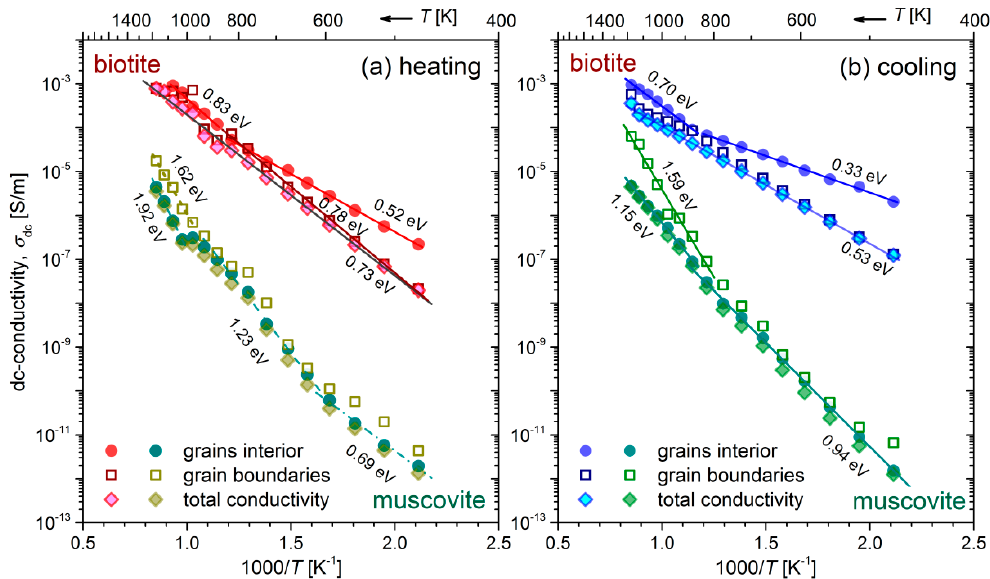
Figure 4. Arrhenius plots of dc-conductivity during the heating-cooling cycle of biotite and muscovite mica samples, during ( a ) gradual heating to 1173 K and ( b ) subsequent cooling to 473 K. The thermal activation energies E a are denoted for each linear region of the plots (refer also to Table 2). For their explanation, see the text.